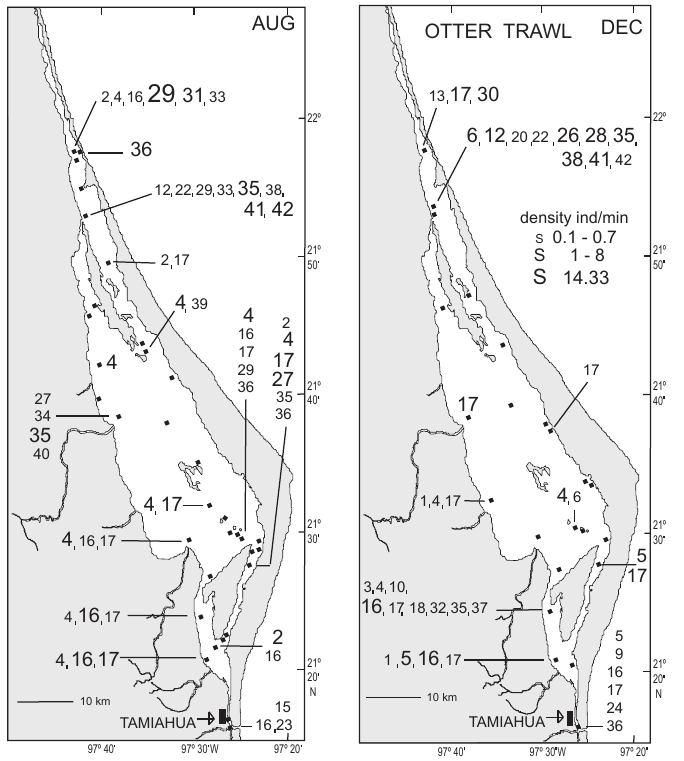
Fig. 3. Laguna de Tamiahua, Gulf of Mexico, Mexico—fish sampling in 1996 with an otter trawl; August = left , and December = right : 1 = Hypanus sabinus , 2 = Ariopsis felis , 3 = Bagre marinus , 4 = Cathorops aguadulce , 5 = Cathorops melanopus , 6 = Opsanus beta , 7 = Eleotris pisonis , 8 = Ctenogobius boleosoma , 9 = Gobionellus hastatus , 10 = Gobionellus oceanicus , 11 = Gobiosoma bosc , 12 = Gobiosoma robustum , 13 = Oreochromis mossambicus , 14 = Lucania parva , 15 = Chloroscombrus chrysurus , 16 = Citharichthys spilopterus , 17 = Achirus lineatus , 18 = Symphurus civitatium , 19 = Hippocampus zosterae , 20 = Syngnathus floridae , 21 = Syngnathus louisianae , 22 = Syngnathus scovelli , 23 = Trichiurus lepturus , 24 = Centropomus ensiferus , 25 = Lutjanus griseus , 26 = Lutjanus synagris , 27 = Diapterus rhombeus , 28 = Eucinostomus argenteus , 29 = Eucinostomus gula , 30 = Eucinostomus melanopterus , 31 = Gerres cinereus , 32 = Conodon nobilis , 33 = Orthopristis chrysoptera , 34 = Chaetodipterus faber , 35 = Bairdiella chrysoura , 36 = Bairdiella ronchus , 37 = Cynoscion arenarius , 38 = Cynoscion nebulosus , 39 = Cynoscion nothus , 40 = Menticirrhus americanus , 41 = Archosargus probatocephalus , 42 = Lagodon rhomboides ; the three S’s in the upper right hand corner of the map on the right represent the sizes of the species’ numbers for the three density